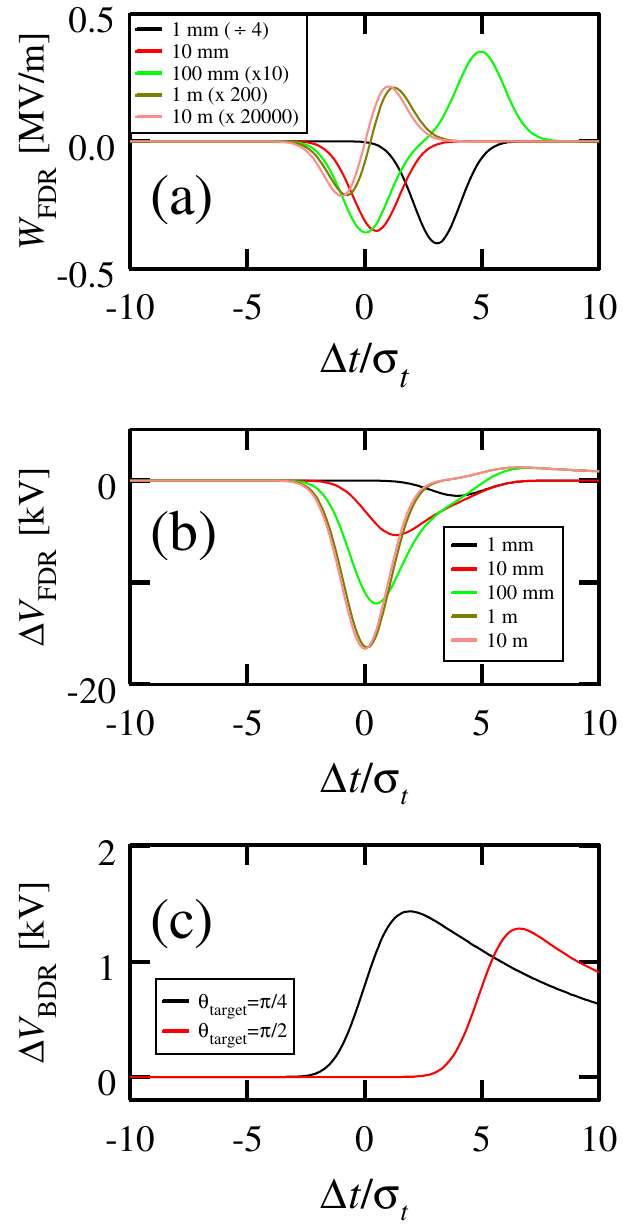
FIG. 3. (Color) Coherent diffraction-radiation (CDR) wakes of a disk target with inner radius of 2 mm and outer radius of 20 mm, for a 511-MeV 200-pC Gaussian bunch with (cid:3) z ¼ 400 (cid:9) m and : 1 (cid:3) r b ¼ 0 z . (a) Forward diffraction-radiation (FDR) wake at five distances downstream of the target. (b) Integrated FDR wake at the same five distances. (c) Integrated wakes of backward diffraction radiation (BDR) for two target